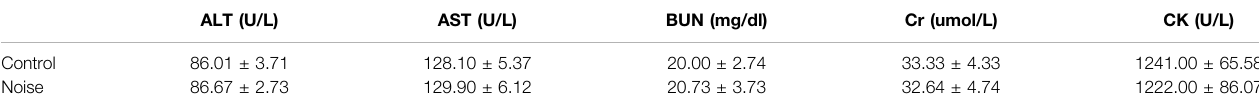
TABLE 1| Serum alanine aminotransferase (ALT), aspartate aminotransferase(AST), blood urea nitrogen (BUN), creatinine (Cr), and creatine kinase (CK) activitiesat day 28. Data are expressed as means ± standard deviation (SD). ALT (U/L) AST (U/L) BUN (mg/dl) Cr